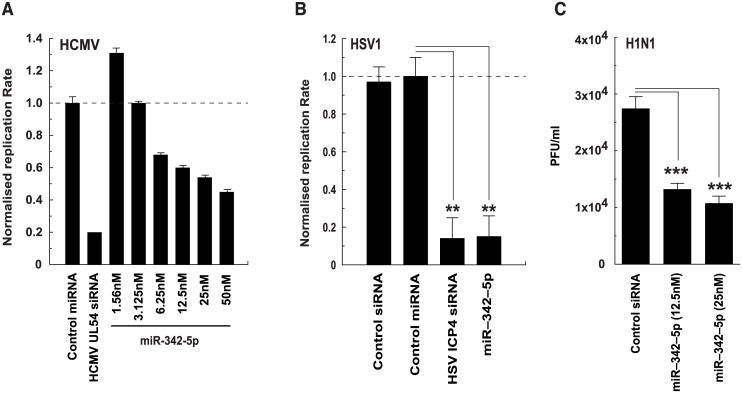
MiR-342-5p exerts a broad antiviral activity.(A) Inhibition of HCMV-GFP in MRC5 cells. Data are normalised to values obtained with C. elegans miRNA and are mean +/− SEM (n = 2). (B) Inhibition of HSV1-GFP in HeLa cells. Data are normalised to values obtained with C. elegans control miRNA and are mean +/− SEM (n = 3), ** p ≤ 0.01. (C) Inhibition of Influenza virus (H1N1). A549 cells were transfected with miRNA for 48 h then infected with H1N1 for 24 h. Infectious virus titre in supernatants was then analysed by plaque assay. Data are mean +/− SEM. Control siRNA and miR-342-5p (25 nM) n = 14. MiR-342-5p (12.5 nM) n = 6. *** p ≤ 0.001.